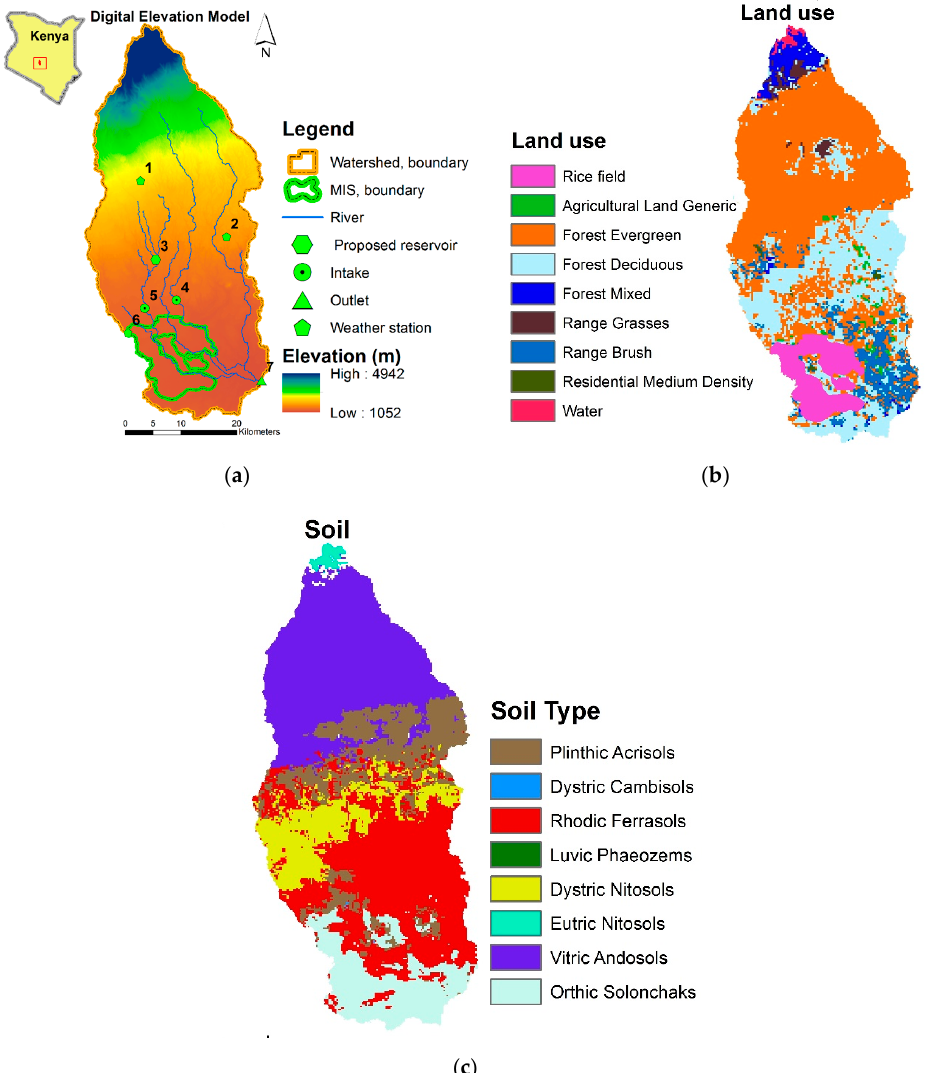
Figure 3. Soil Water Assessment Tool (SWAT) model study area ( a ) topography map; ( b ) land use map; ( c ) soil map.